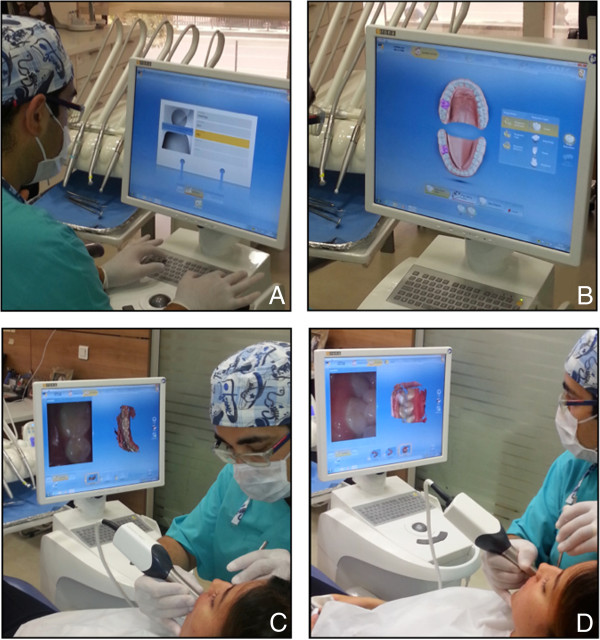
Digital impression technique. A) Entering patient information, B) Laboratory prescription, C) Upper and lower arches scanning, D) Bite scanning.